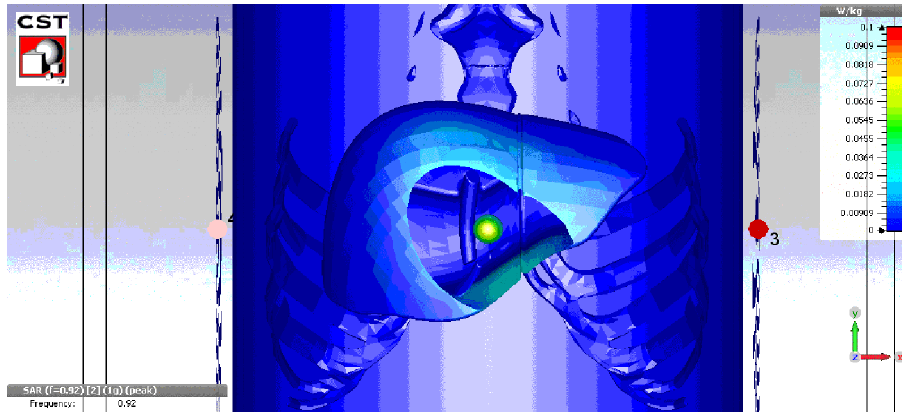
Figure 9: SAR by using (PAS) antennas at frequency 915